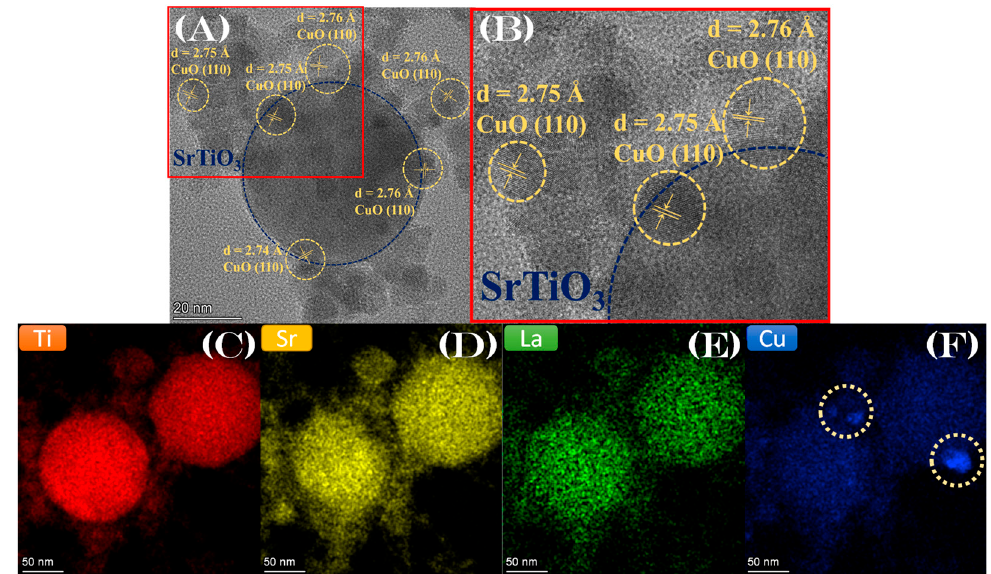
Figure 3. ( A,B ) HRTEM images for the particle La:STO/Cu, with the distinct miller planes of CuO (110) deposited on the SrTiO 3 surface. ( C – F ) Scanning-TEM images with Ti, Sr, La, and Cu atom mapping for material La:STO/Cu.